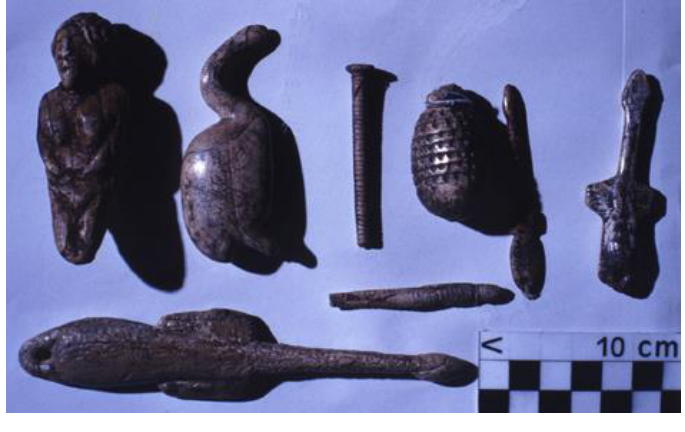
Figure 1. Eight of the ivory objects from Mal’ta, near Irkutsk, Siberia, probably close to 15,000 years